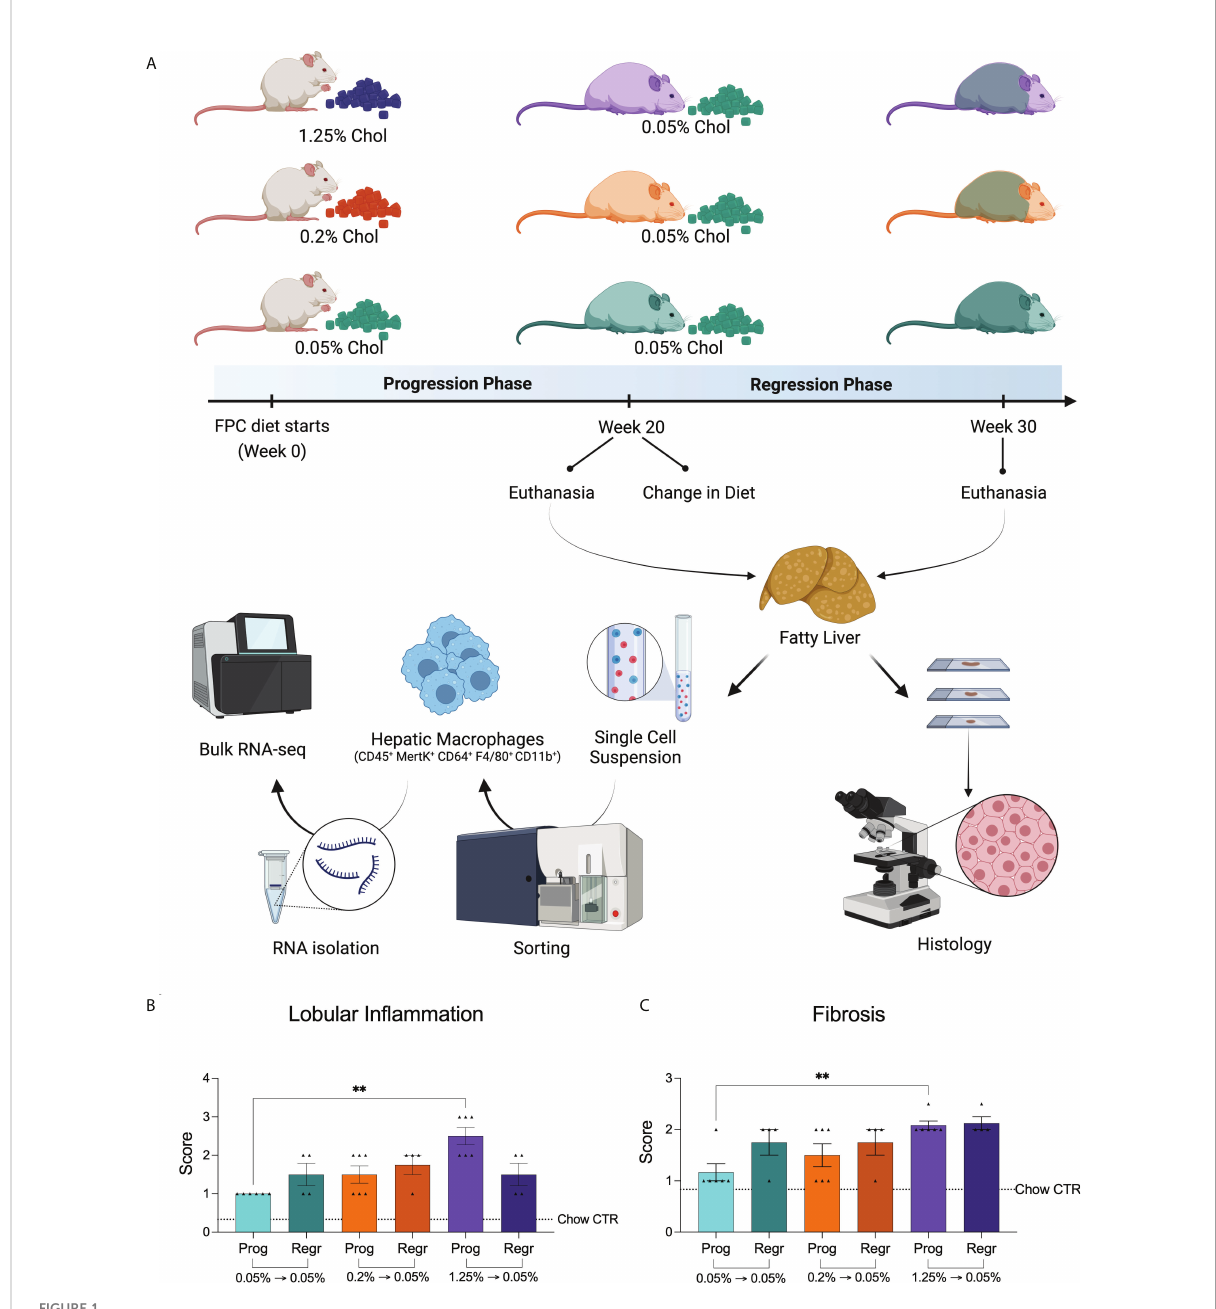
FIGURE 1 Experimental design and dietary cholesterol impact on murine NASH model. (A) For our NASH model, we selected the Fructose, Palmitate, Cholesterol, and Trans-Fat (FPC) diet. We evaluated the mice in two distinct phases. During the fi rst 20 weeks (progression phase), we fed male C57BL/6J mice with the FPC diet containing different concentrations of cholesterol: 1.25% (high, purple), 0.2% (medium, orange), and 0.05% (low, green). At week 20, we reduced the dietary cholesterol intake for the 1.25% and 0.2% groups, keeping all mice on the FPC diet with 0.05% cholesterol for additional ten weeks (regression phase). At the end of each phase, we harvested mice livers, sorted hepatic macrophages, and processed them for RNA-seq analysis. NASH was assessed on the liver specimens based on histologic fi ndings (Created with BioRender.com). (B) Lobular in fl ammation and Fibrosis (C) were exacerbated in mice fed with high cholesterol FPC diet during the progression phase (n = 6 for progression and n = 4 for regression phases). Statistical test used: Kruskal-Wallis, **P value < 0.01. Prog, Progression phase; Regr, Regression phase; CTR,